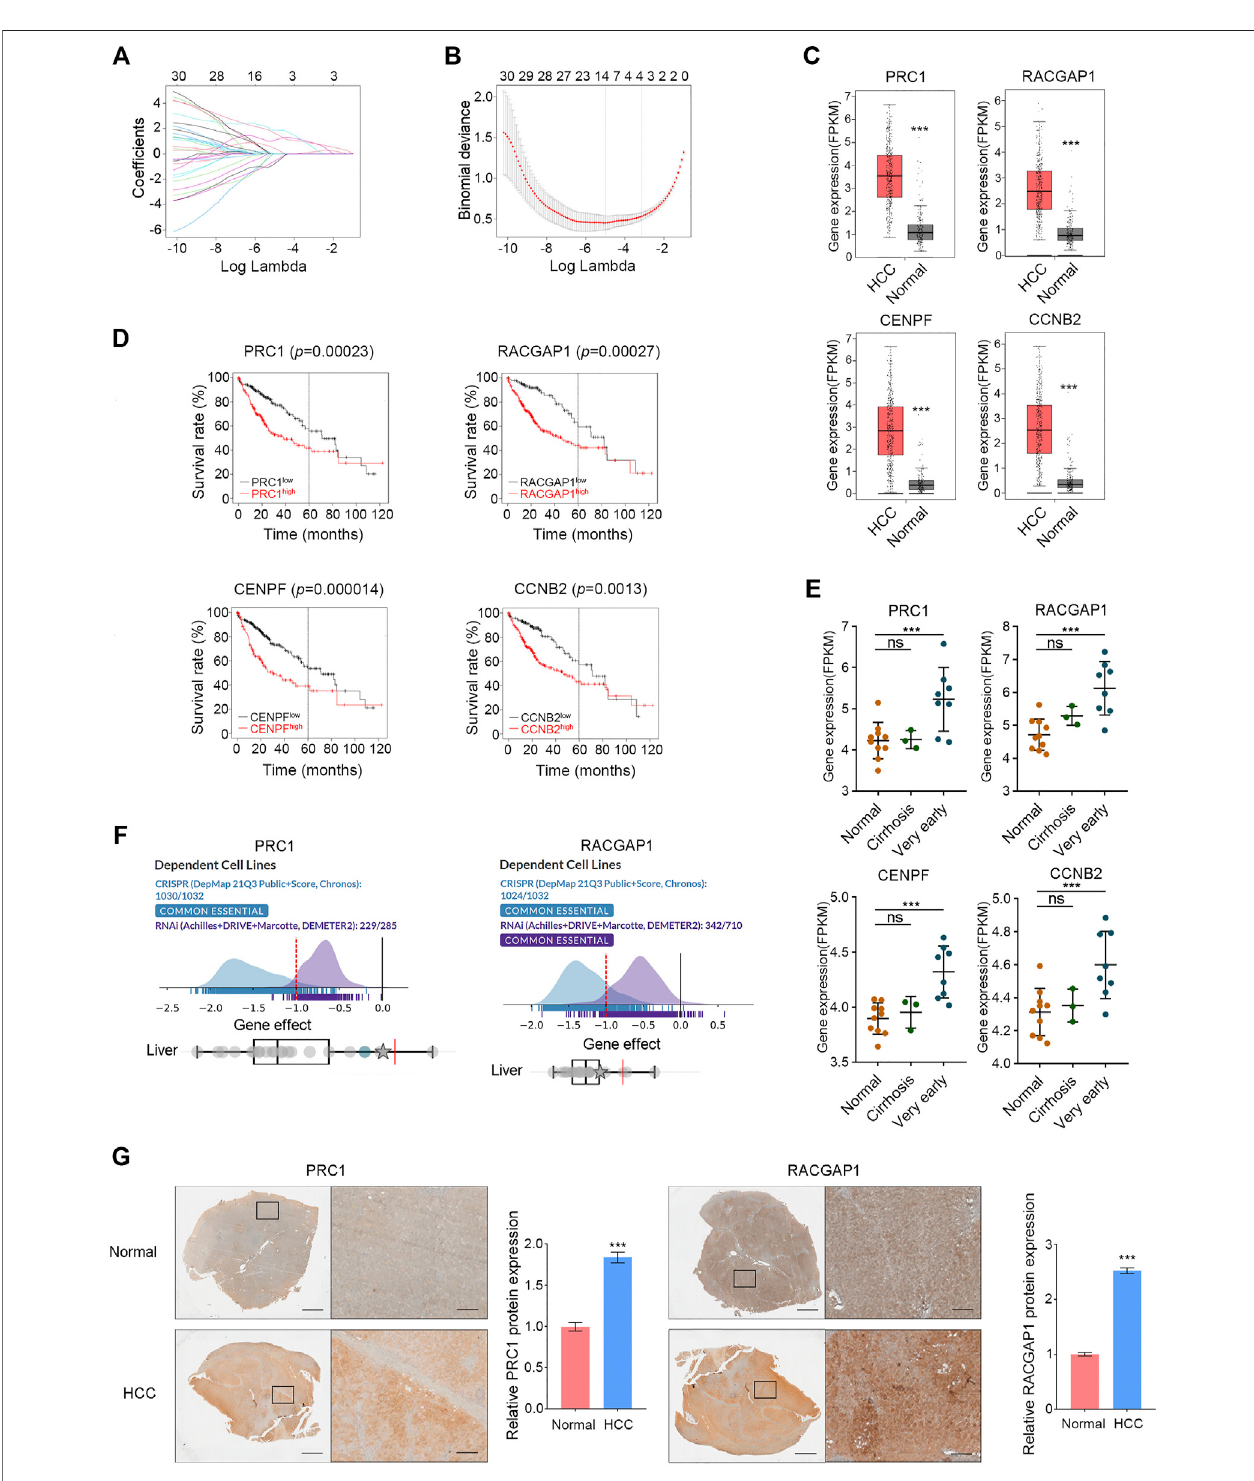
FIGURE2| Validation ofhub genesinHCC. (A,B) PRC1,RACGAP1, CENPF,and CCNB2 werescreenedbyLASSO. (C) IntheGEPIAdatabase,high expression of PRC1, RACGAP1, CENPF, and CCNB2 in HCC was veri fi ed. (D) Overexpression of PRC1, RACGAP1, CENPF, and CCNB2 is associated with poor OS in HCC patients. (E) Compared with normal tissues, PRC1, RACGAP1, CENPF, and CCNB2 were overexpressed in very early HCC samples, but there was no signi fi cant difference in cirrhosis samples. (F) PRC1 and RACGAP1 were shown as essential genesin the DepMap database. (G) Quantitative immunohistochemical study of PRC1 and RACGAP1 in HCC and normal liver tissues. Scale bars, overall plots, 1 mm, local plots, 100 μ m. ns p ≥ 0.05; *** p < 0.001, data are shown as mean ± s.d.